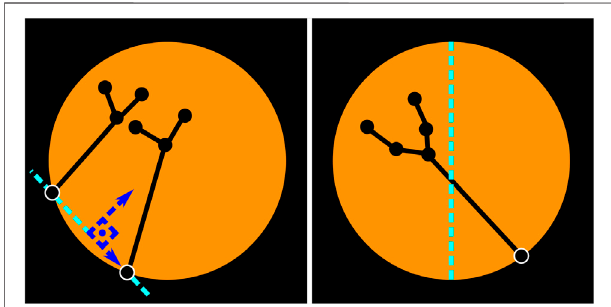
FIGURE 7 | Left/right instrument identi fi cation. Two-instrument case (left). Single-instrument case (right). The location of the entrypoints is used to identify whether the instruments are left/right. When two instruments are visible, an imaginary vertical line (parallel to the vertical axis of the image) thatcrossesoverthecentralpointofthesegmentconnectingbothentrypoints is used to determine if the instrument is left/right. When there is only one instrument,thelocationoftheentrypoint withregardstotheverticalaxis ofthe imagedetermines which tool isvisible. Ifthe entrypoint residesin the right half, as in the fi gure above, this is considered to be the right